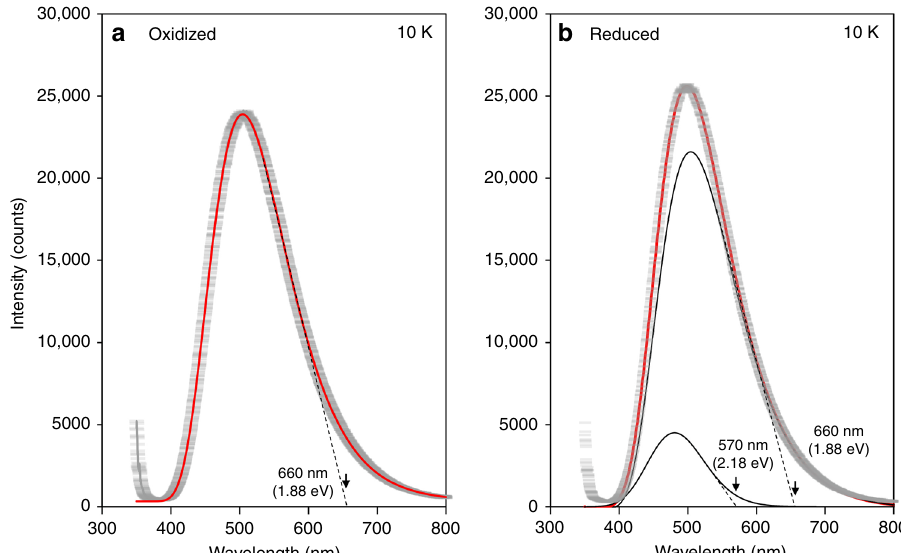
Fig. 8 Photo-luminescence (PL) spectra. The PL data (gray crossbar) were collected at 10 K for the single-crystal samples. The pro fi le of the oxidized sample can be traced by a single log-normal function (red curve with H = 23,548, λ 0 = 341.5 nm, w = 369.1nm, and ρ = 1.50). In contrast, that of the reduced sample could not be fi tted by a single function and is well reproduced by a superposition (red curve) of two log-normal functions (black lines): the parameters of the large peak are H = 21,720, λ 0 = 341.5 nm, w = 369.1 nm, and ρ = 1.50, and those of the small peak are H = 4,502, λ 0 = 148.0nm, w = 263.4 nm, and ρ = 1.16. The oxidized sample displays a long-wavelength edge (LWE) of ≈ 660 nm (1.88 eV), while the reduced sample exhibits LWEs of ≈ 660 nm (1.88 eV) and ≈ 570 nm (2.18